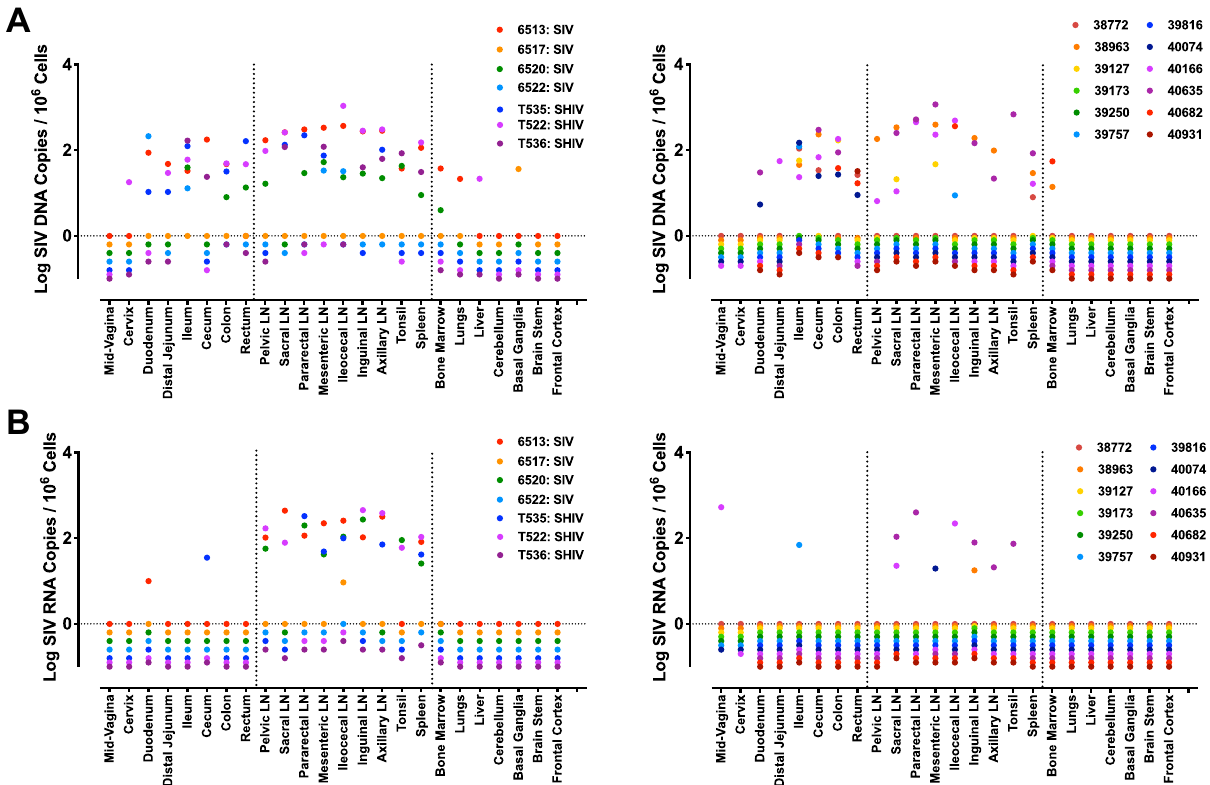
Fig. 2 Viral DNA and viral RNA in tissue necropsies from Late and Early ART-suppressed rhesus monkeys. A Copies of total viral DNA and B viral RNA from 24 tissue necropsies from the Late ART (left) and Early ART (right) studies. Log SIV DNA copies/10 6 cells and log SIV RNA copies/10 6 cells are shown. Colors re fl ect individual animals. Assay sensitivity was >8 – 10 SIV DNA copies/10 6 cells and 10 SIV RNA copies/10 6 cells. SIV, simian immunode fi ciency